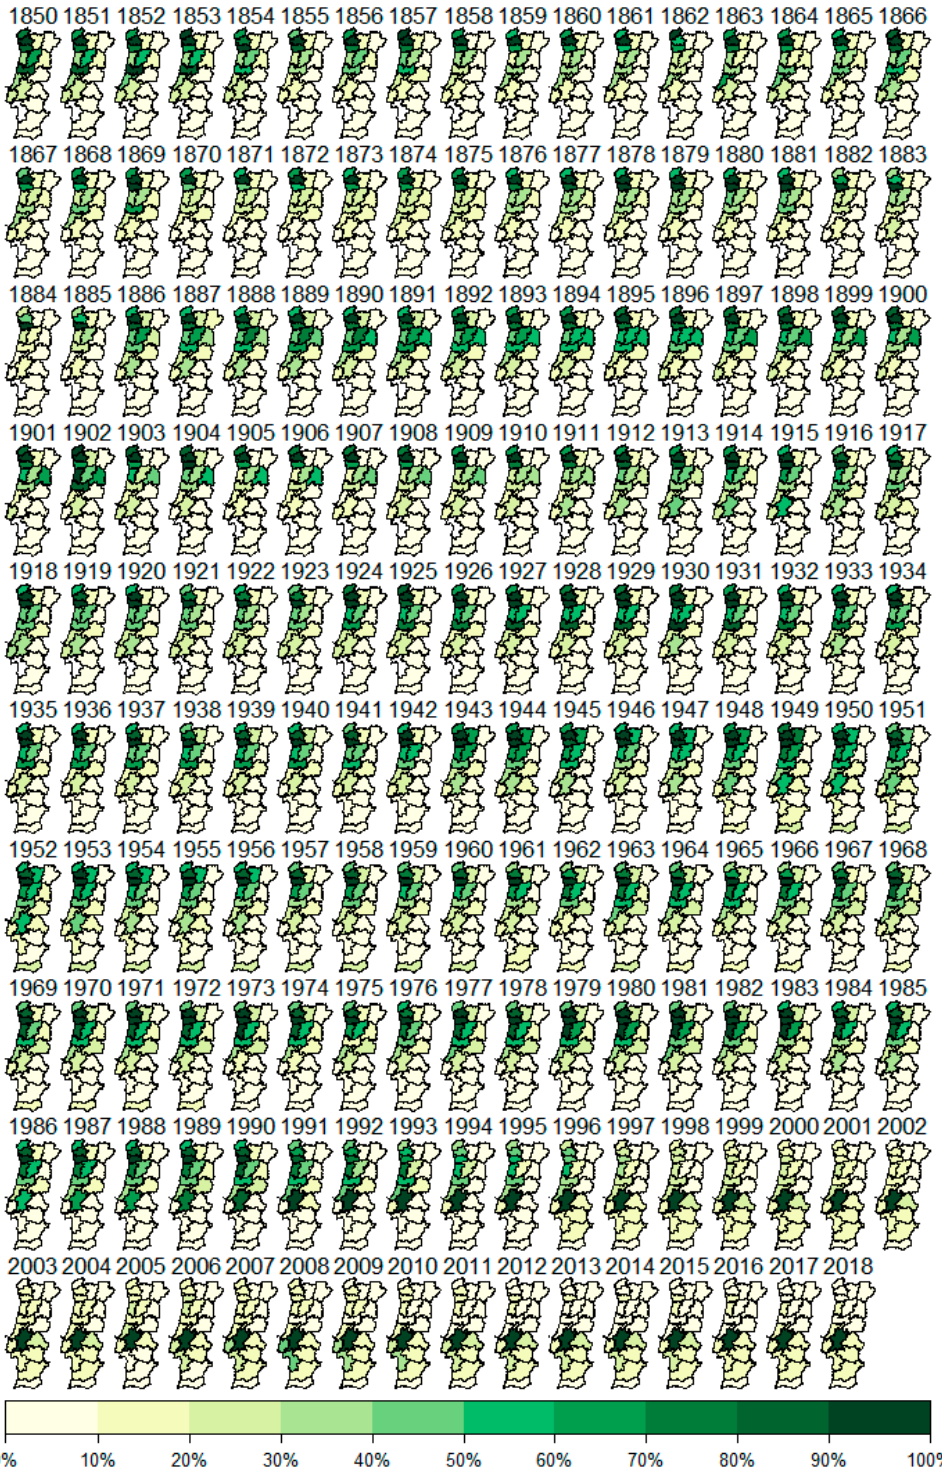
Figure 8. Spatiotemporal pattern of maize production (1850–2018).